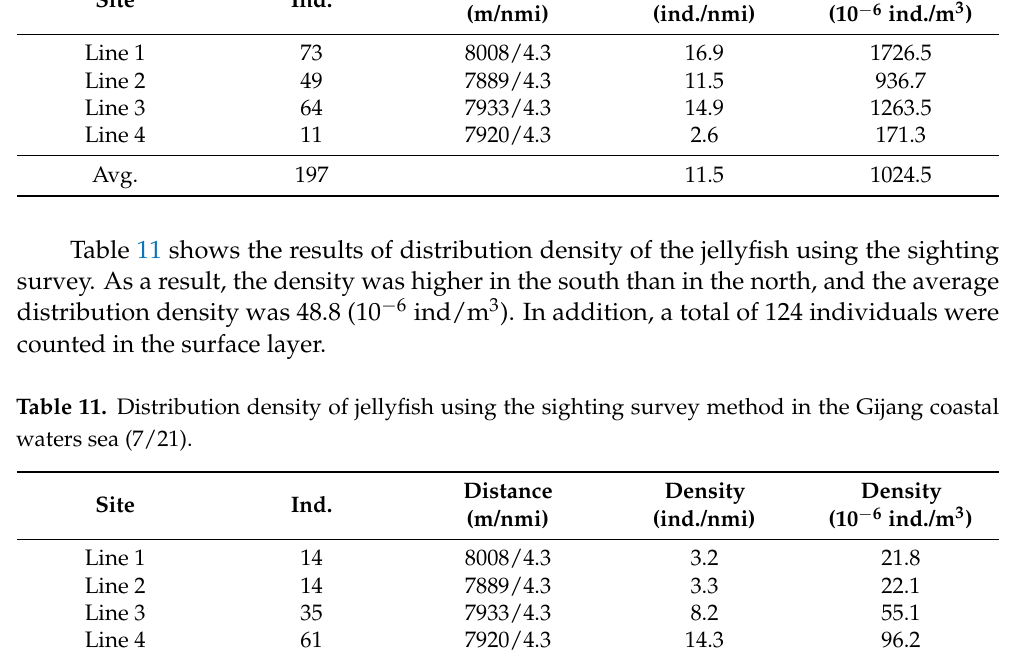
Table 10. Distribution density of jellyfish using the echo counting method in the Gijang coastal waters sea (7/21). Site Ind.